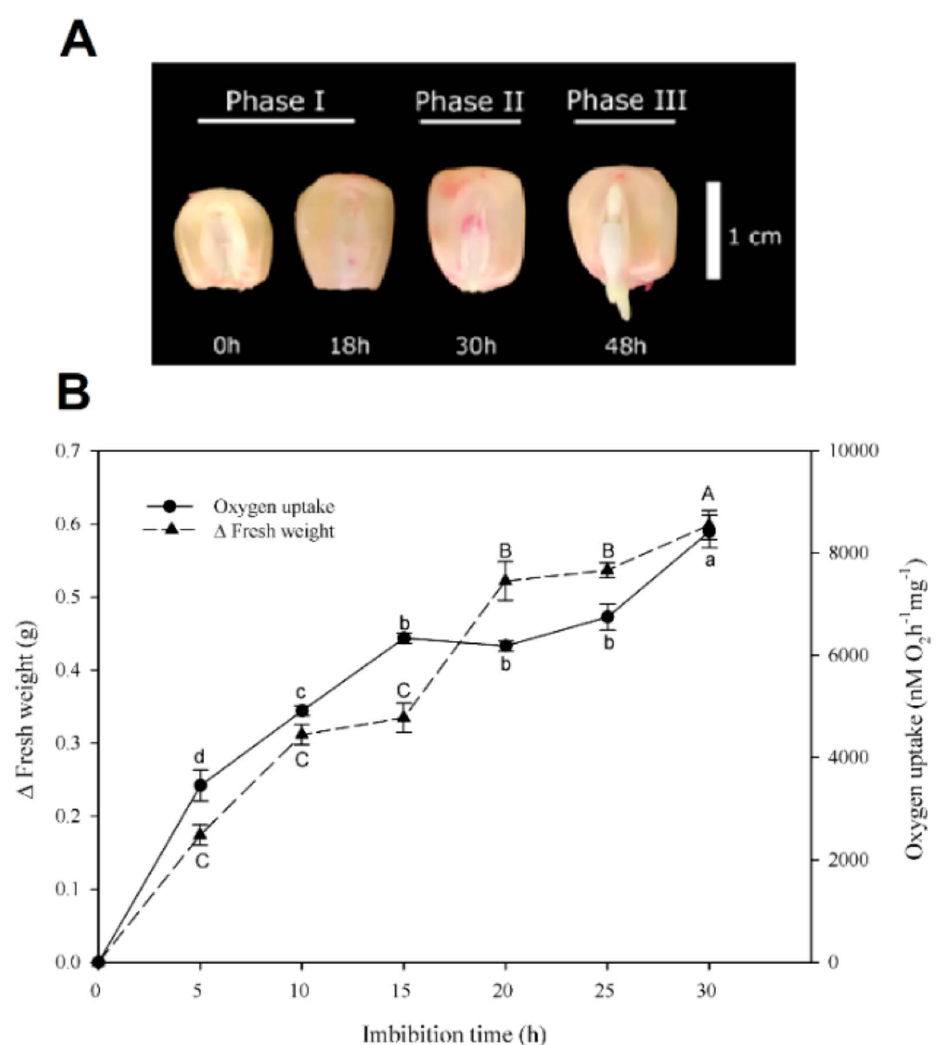
Figure 1. Seeds germinated at di ff erent times and embryo hydration and oxygen uptake during germination. ( A ) Seeds were germinated at di ff erent times; the germination phases are indicated. ( B ) Hydration and oxygen uptake curves of embryos isolated from imbibed seeds. Seeds were imbibed in agar 1% and incubated at 29 ◦ C at the indicated times; later, the fresh weight and oxygen uptake of isolated embryos were determined. The values are the average of three independent experiments ± SD. Di ff erent letters indicate statistically significant values according to the Tukey test, p < 0.05. Capital letters indicate oxygen uptake and lowercase letters indicate fresh